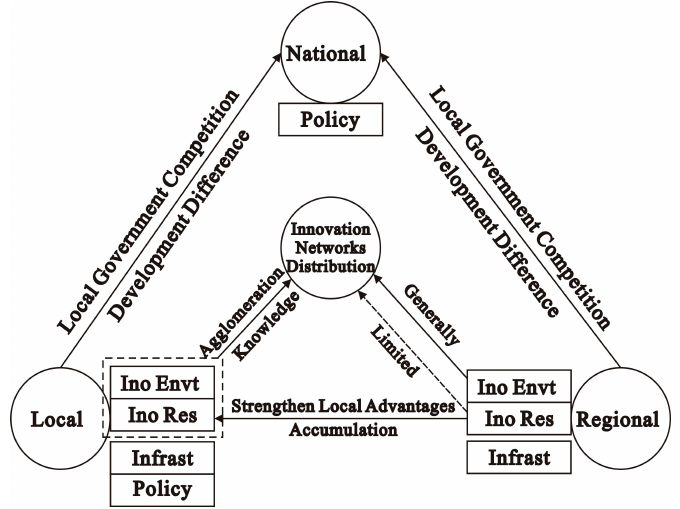
Figure 3. The multilevel mechanism of innovation networks distribution in China’s NEV industry.